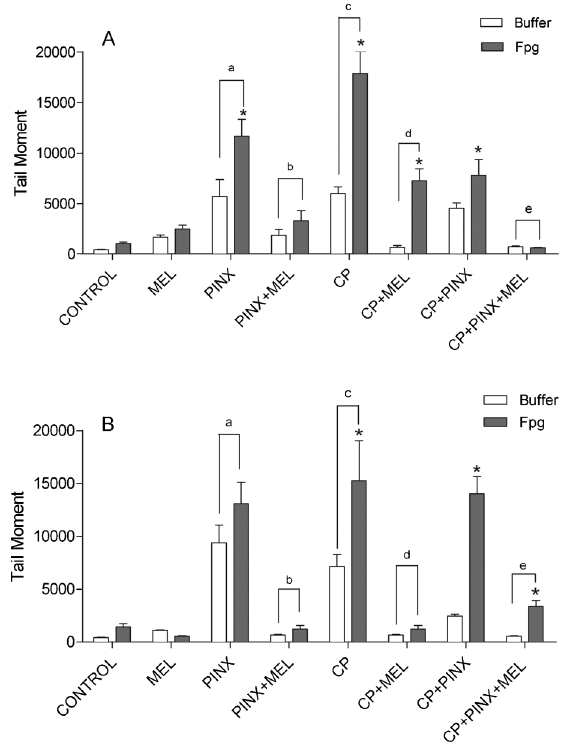
Figure 2. A , Quantification of Fpg-sensitive sites by the Fpg- comet assay 24 h after treatment with 50 mg/kg cyclophos- phamide (CP). The damage measured by alkaline comet assay was estimated as the percentage of DNA in the tail after treatment with Fpg (filled bars) and buffer without Fpg (open bars). Tail moment (numerical measurement of DNA damage) is